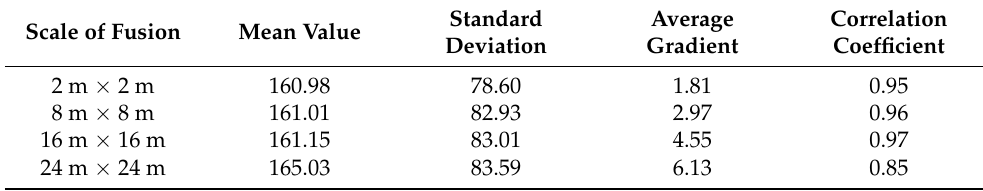
Table 3. Evaluation indices of different scale fused images of local area.